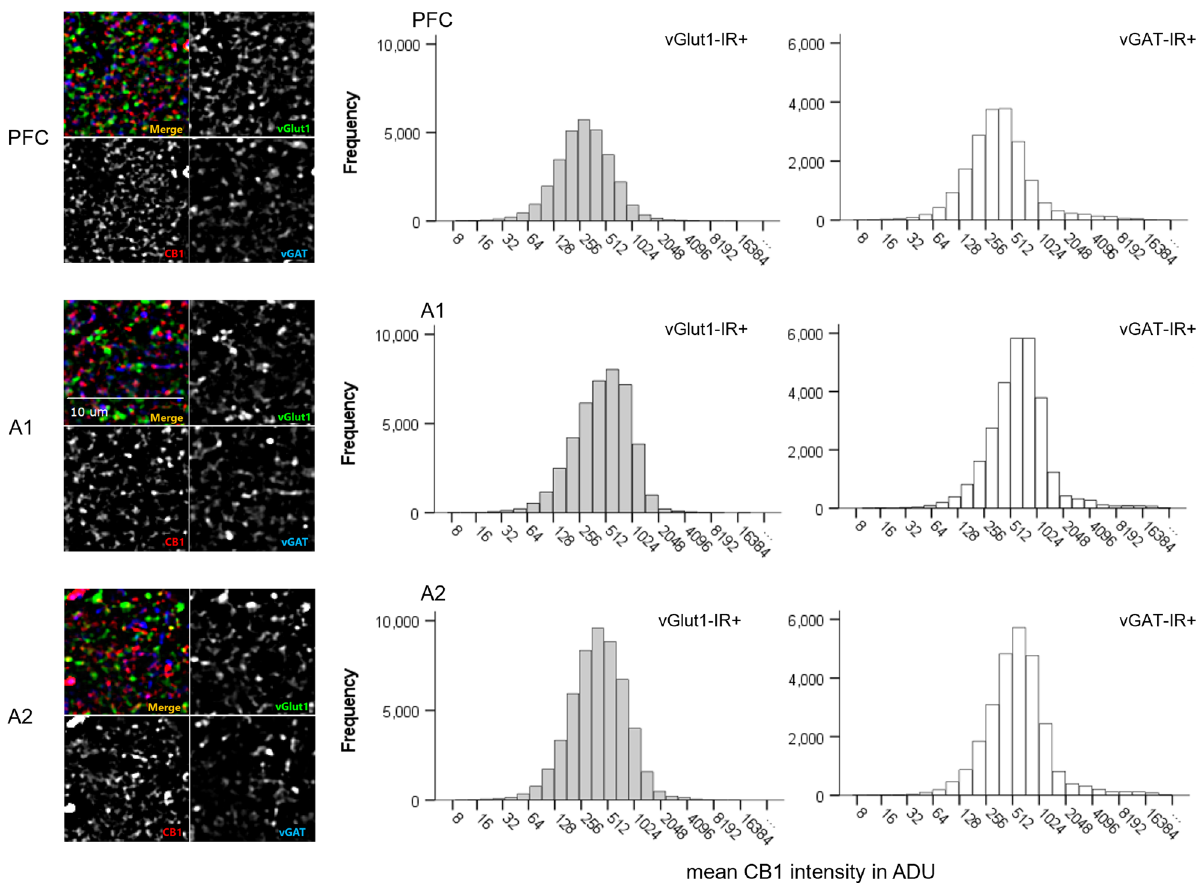
Figure 4. Mean CB1R intensity frequency histograms for excitatory (vGlut1-IR +) and inhibitory (vGAT-IR +) cell types across three brain regions of the human cortex, measured in analogue-to-digital units (ADU). PFC = prefrontal cortex, A1 = primary auditory cortex, A2 = association auditory cortex. Scale bar can be seen in the sample image for